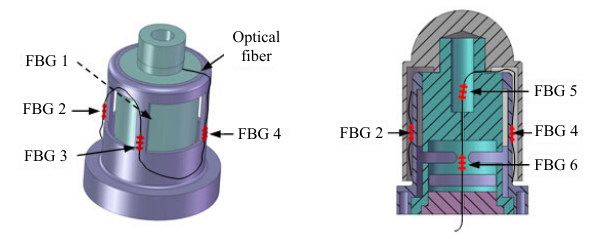
Fig. 10 Structure of the three-axis force fingertip sensor.